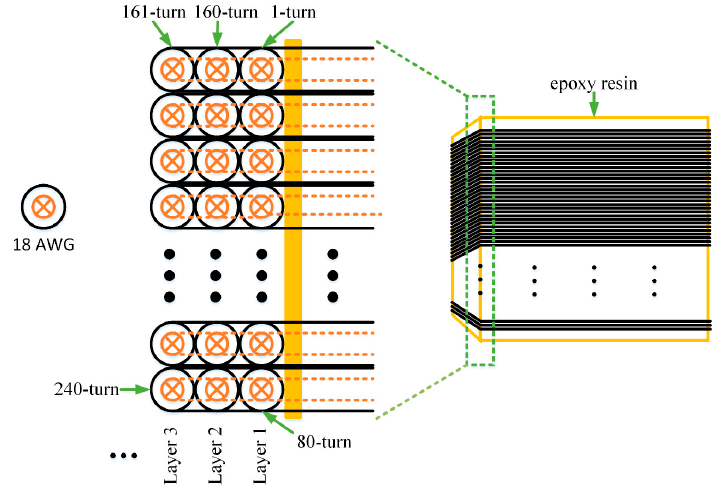
Figure 1. The structure of multi-turn coil. Each layer has 80-turn tight winding and the skeleton is made of epoxy resin.